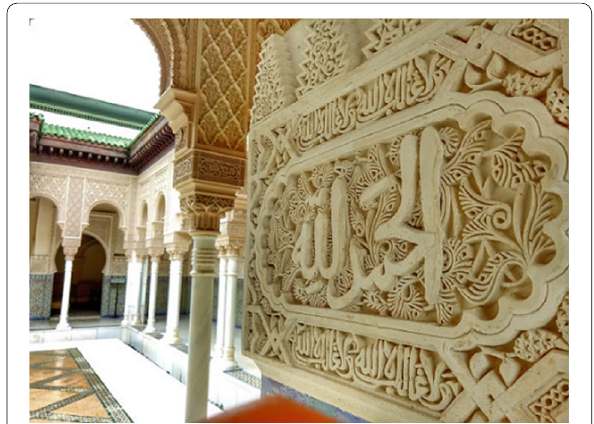
Fig. 5 Astaka Morocco, the Islamic calligraphy element. Source (illashanahila 2017) Fig. 6 Exterior view of Putra mosque (Erin Tracy